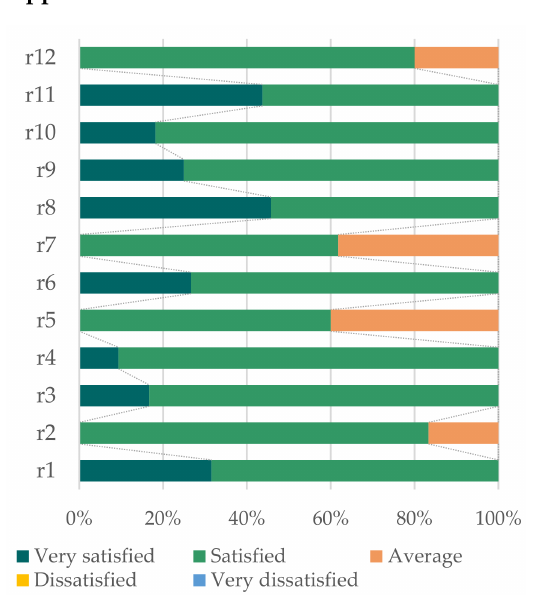
Figure A13. User satisfaction in Liuhuahu